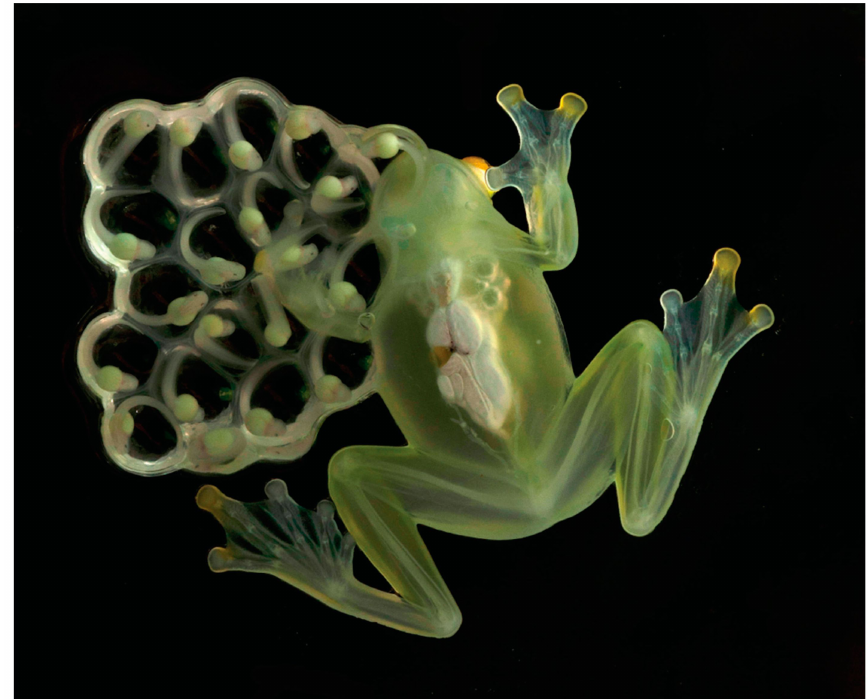
Figure 5. Parental care in glassfrogs. Adult male of Hyalinobatrachium aureoguttatum , with egg clutch. Photo by Luis A. Coloma.